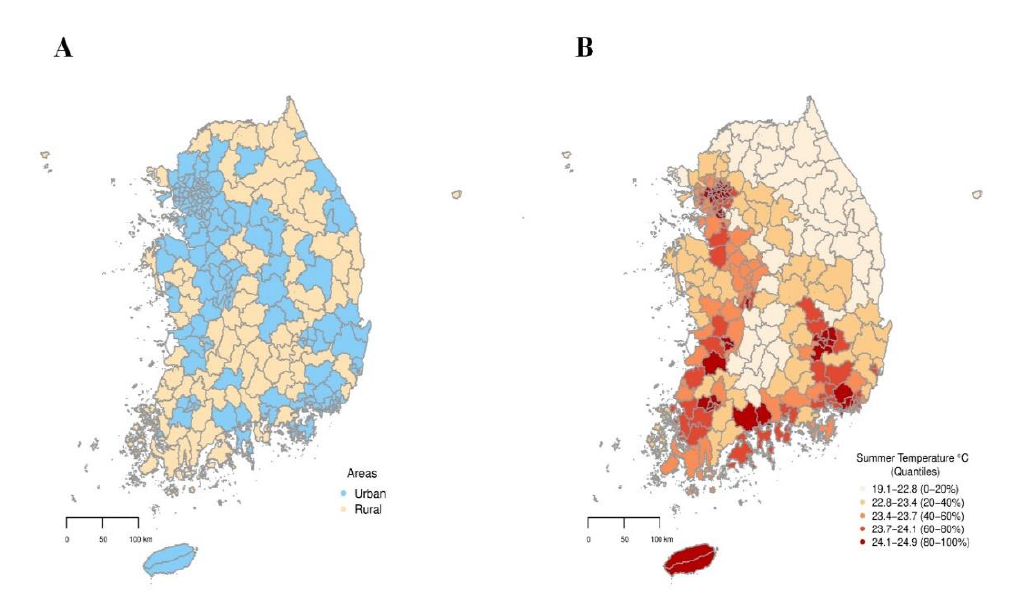
Figure 1. Geographical distributions of urban and rural districts ( A ) and average summer temperatures ( B ) in South Korea during 2011–2017.